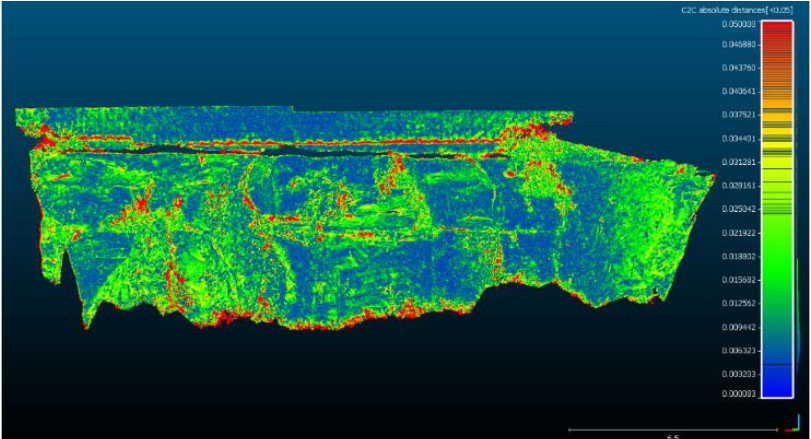
Figure 6. Colour map of absolute distance differences between the TLS model and the block T2.1 photogrammetric digital model in the range of 5 cm for T2.